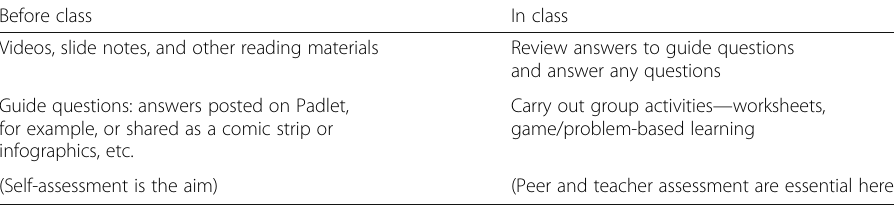
Table 1 Proposed flipped learning format for activities at home and in class Before class In class Videos, slide notes, and other reading materials Review answers to guide questions and answer any